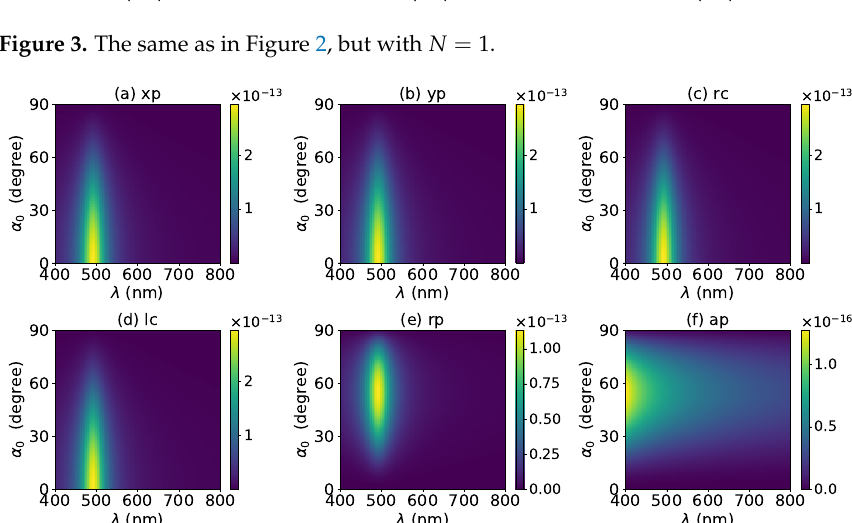
Figure 4. The same as in Figure 2, but with N =